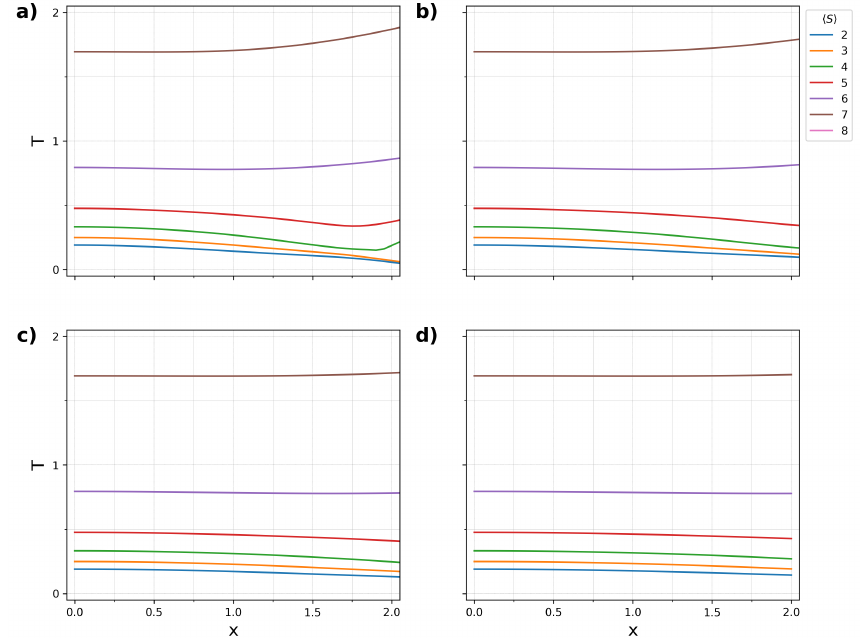
Figure 8. This figure shows the behavior of the temperature, as a function of the dimensionless parameter x , at constant values of the entropy. The entropy S takes the values 2 to 8, in steps of one, in increasing order from the down curve to the up curve. As in the previous figures, ( a – d ) stand for values of the asymmetry parameter α = − 1.25, − 1.0, − 0.75, and − 0.362, respectively.